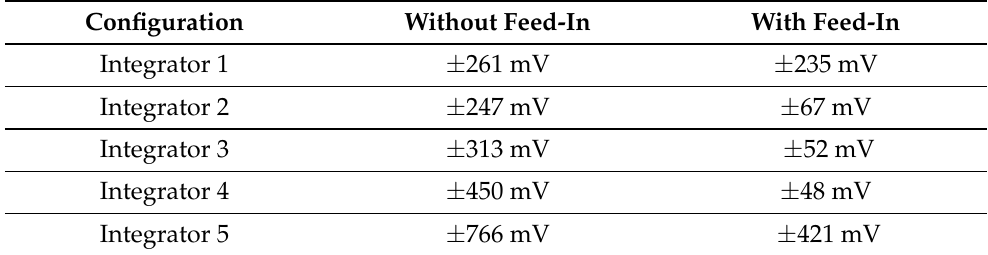
Table 1. Maximum output swing of the modulator fin = 10MHz A in = tizer FS =